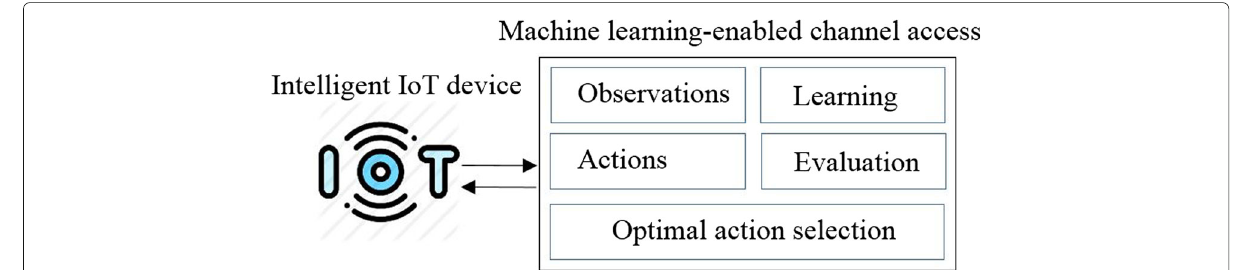
Fig. 2 Intelligent channel access mechanism for IoT-based